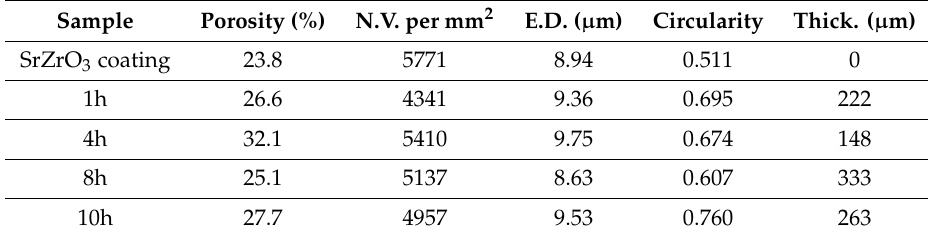
Table 1. Image analysis